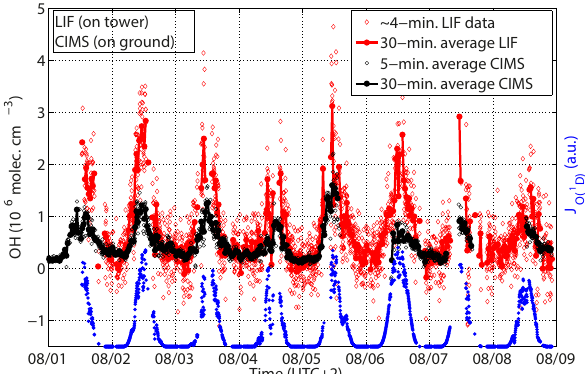
Figure 7. Simultaneous OH measurements on the ground and above the canopy. Concentration maxima observed on the tower are up to a factor of 3 times higher than on the ground. Both instruments measured similar values during night. On-tower J indicated in blue.